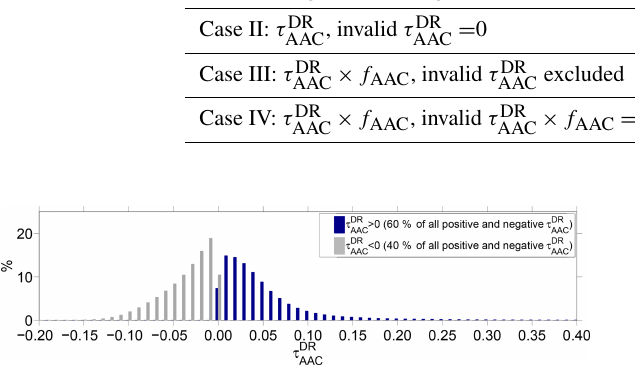
Figure 3. Global distribution of τ DR at 532nm. Positive (i.e., AAC valid) τ DR values are in dark blue ( N ∼ 3 . 4 million) and nega- AAC tive τ DR values in grey ( N ∼ 2 . 2 million). These are nighttime AAC CALIOP measurements from 2008 to